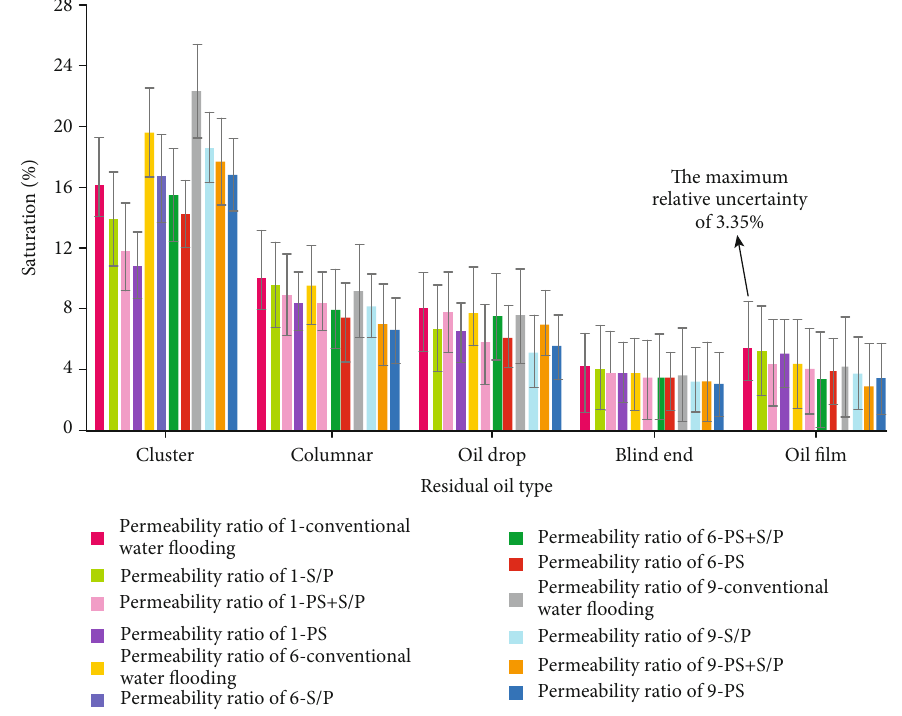
Figure 8: Saturations of various residual oils after di ff erent oil displacement measures.